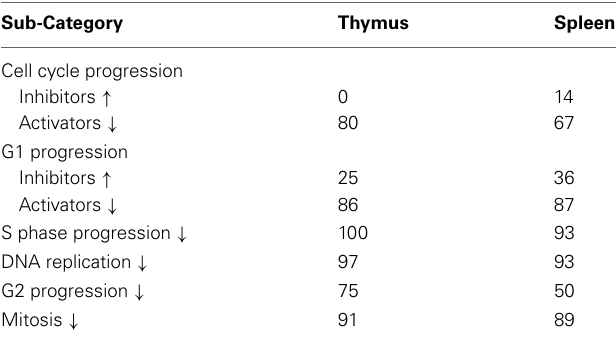
Table 1 | Expression changes of cell cycle